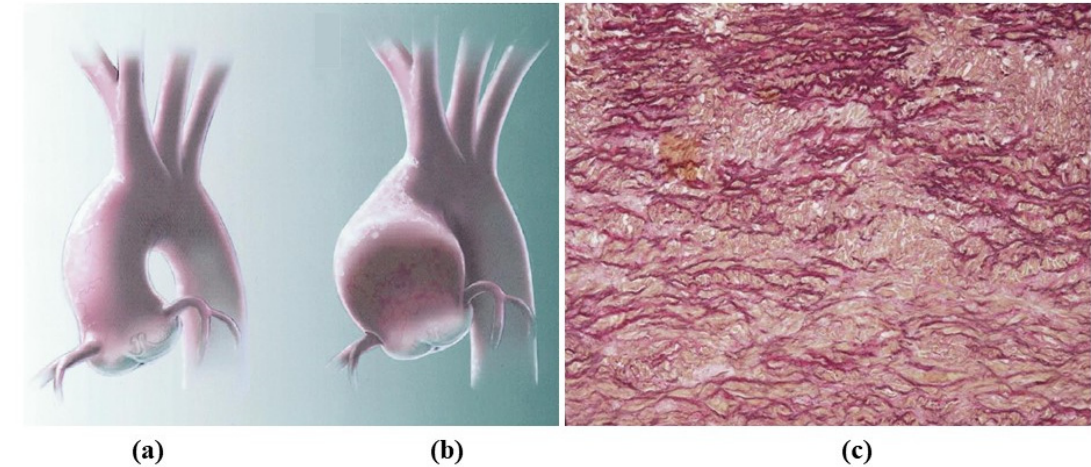
Figure 5. Aortopathy in the bicuspid valve. Note normal ( a ) vs. dilated ( b ) ascending aorta with loss of lamellar units at histology ( c ). (Weigert Van Gieson stain).